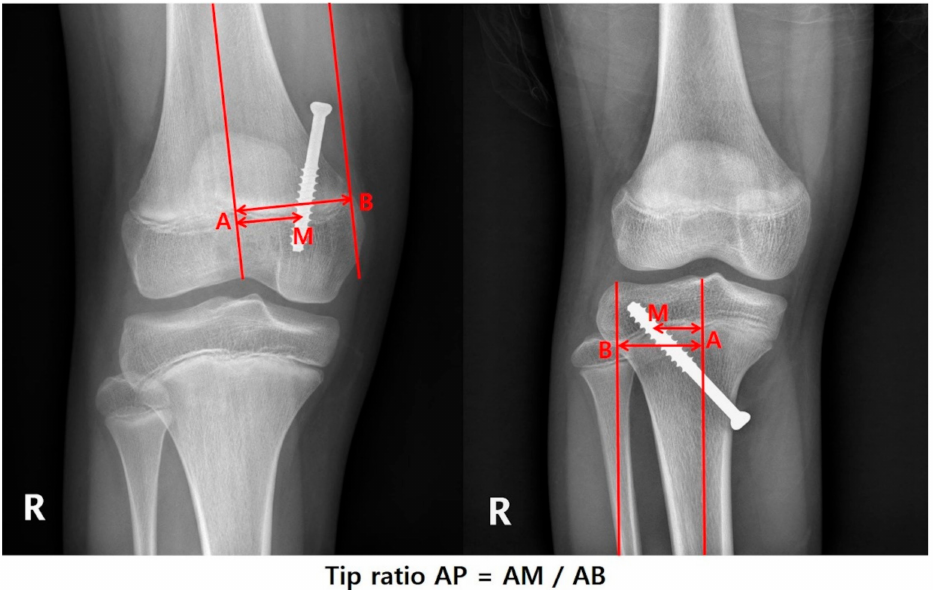
Figure 1. On the knee anteroposterior (AP) view, the screw position was determined as the ratio of AM (distance from center to screw) and AB (distance of half